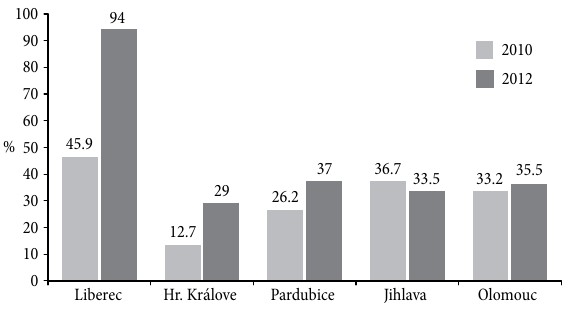
Fig. 2. Comparison of train accessibility on